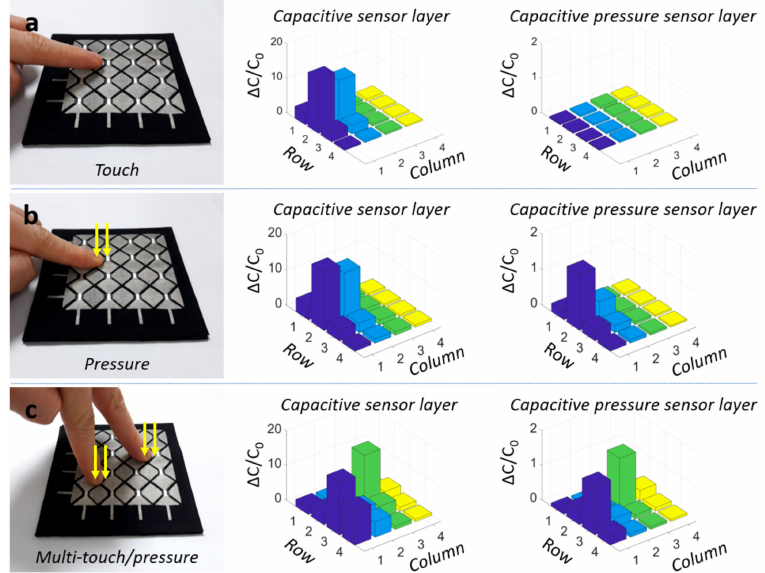
Figure 9. Demonstration of e-fabric-skin in the di ff erent motions consisting of ( a ) touch, ( b ) pressure, and ( c ) multi-touch /